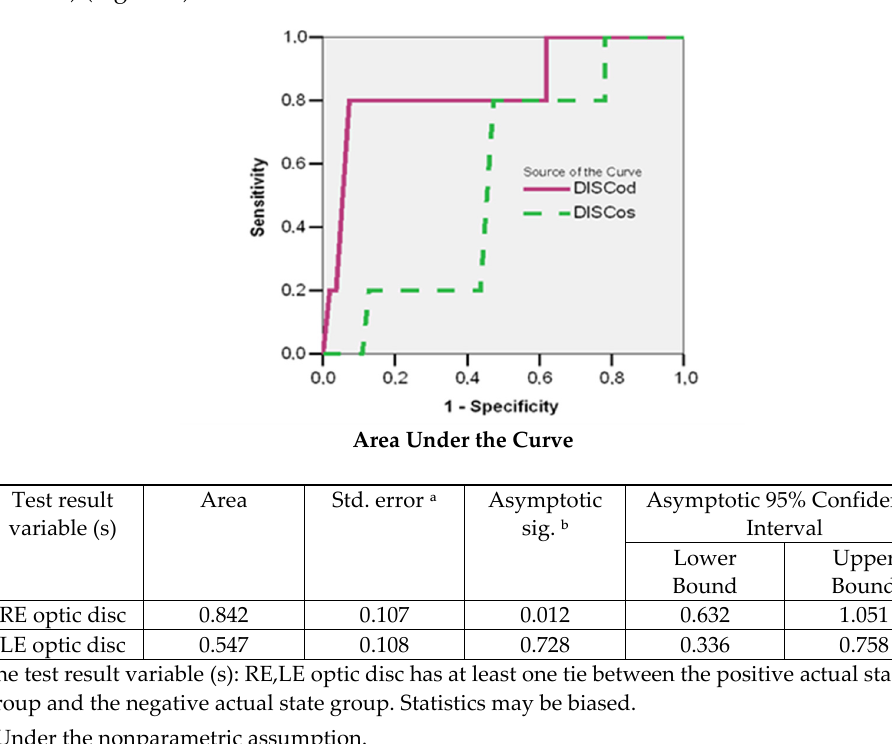
Figure 4. Severe SAS-dependent variable. Predictor of optic disc area.